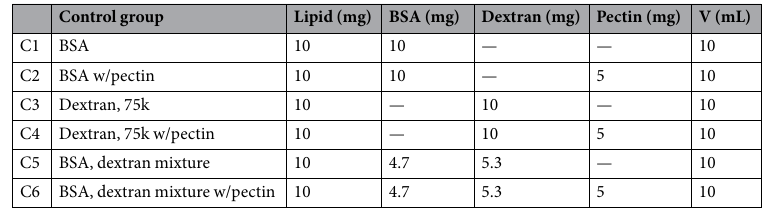
Table 2. Formulations for control